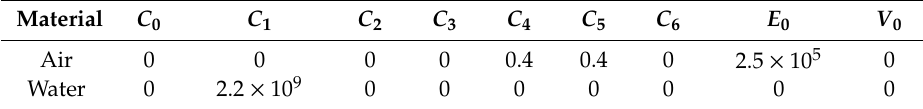
Table 1. E 0 and V 0 indicate the initial internal energy per unit reference volume and initial relative volume, respectively. Table 1. Parameters of the test model. Table 1. Parameters of the test model.